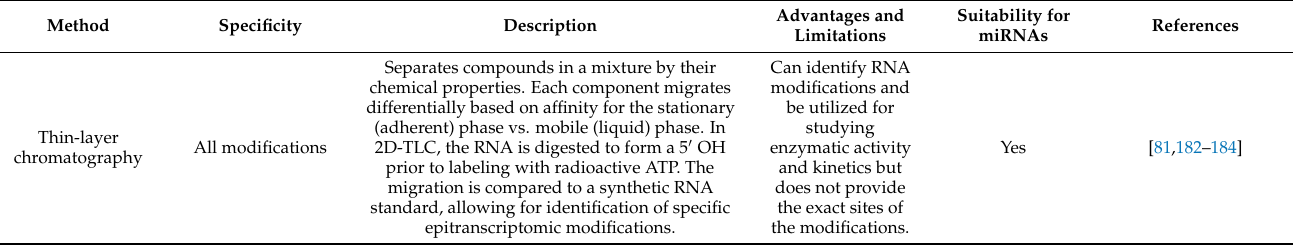
Table 1. Techniques utilized for studying epitranscriptomic